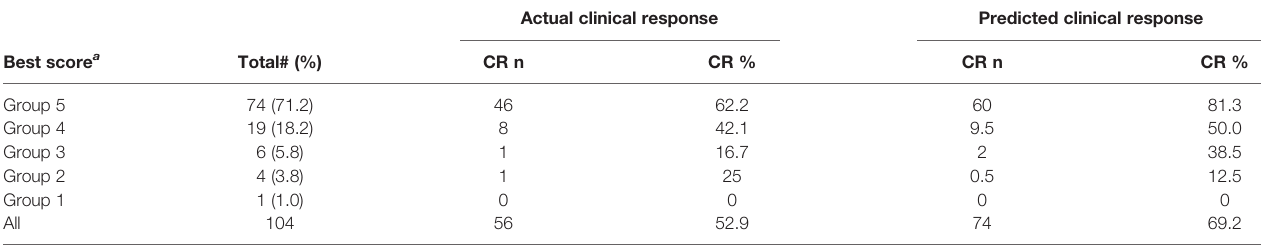
TABLE 3 | A comparison of clinical